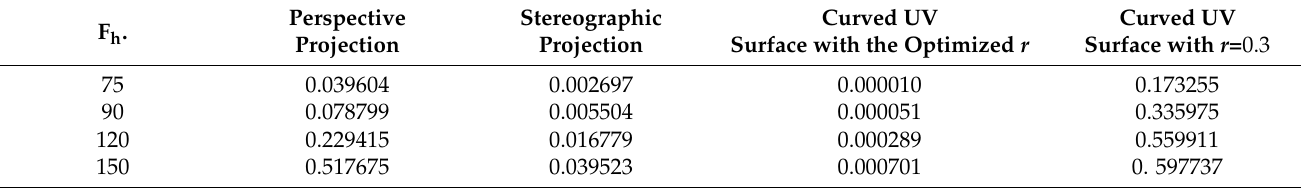
Table 1. Degradation evaluated with (44) for the various techniques.